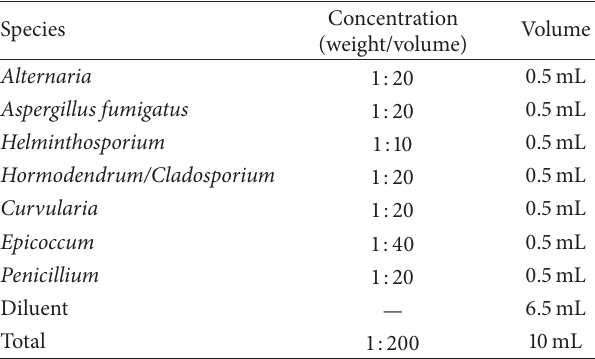
Table 2: Maintenance allergy immune-therapy dose composition for our presented case